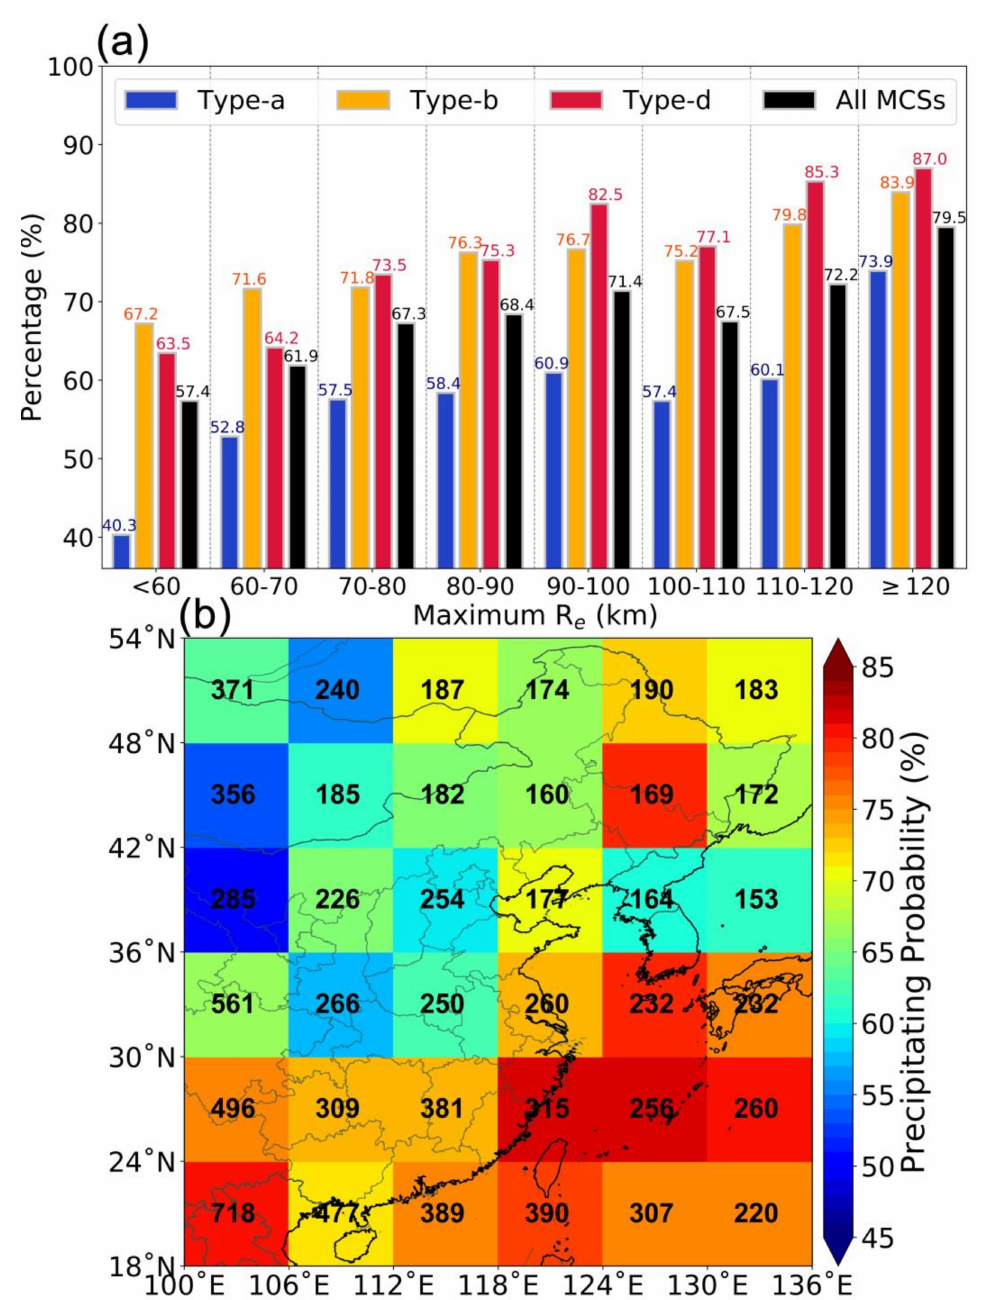
Figure 5. ( a ) Bar plots showing the statistics of precipitating probability of potential MCSs as a function of maximum equivalent radius (R e ) during their lifetime as detected by the Advanced Himawari Imager (AHI) on board the Himawari-8 satellite (HW8), which is grouped by Type a (in blue), Type b (in yellow), Type d (in red), and all MCS cases (combination of Type a, Type b and Type d, in black). ( b ) Spatial distribution of the precipitating probability (color-shaded) of potential MCS cases detected by AHI. Note that the numbers denote the number of samples for each 6 ◦ by 6 ◦